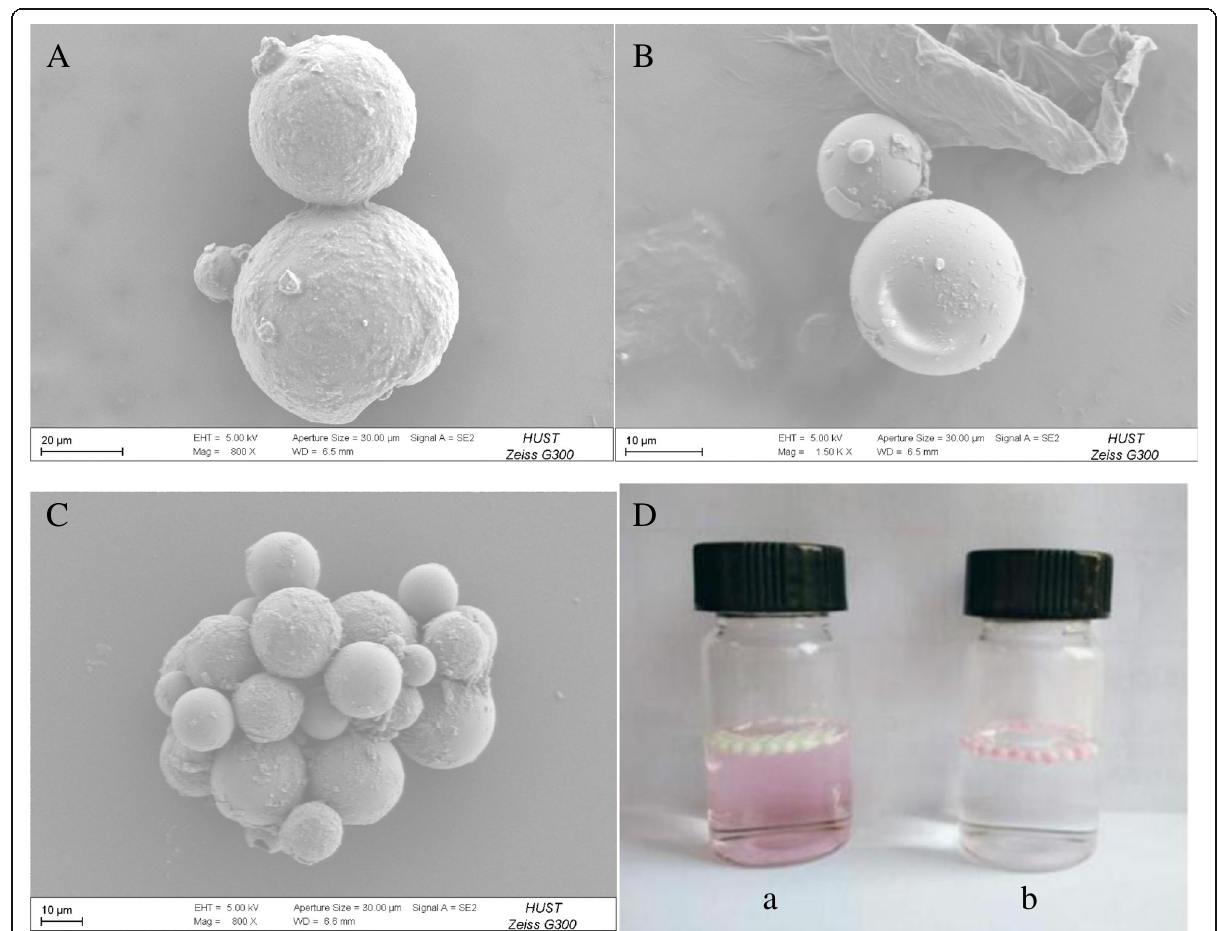
Fig. 2 SEM images of untreated HGMs ( A ), ALG/3-APTS/HGMs ( B , C ). D Comparative photos of ALG/3-APTS/HGMs before (a) and after (b) amaranth